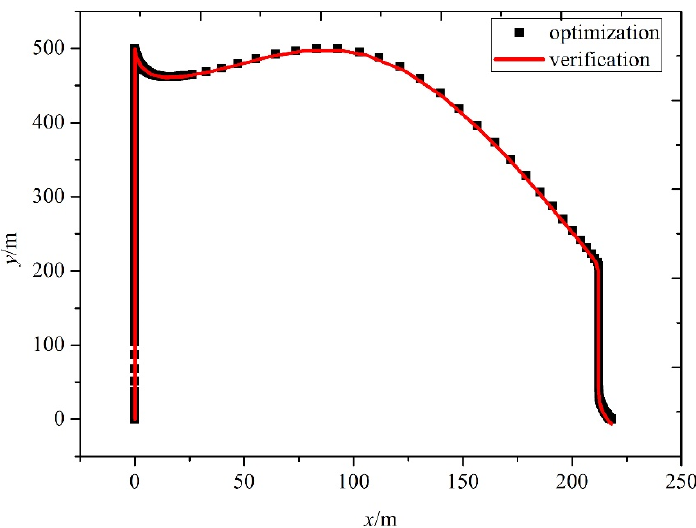
Figure 13. Flight trajectory under case 1 in the third scenario .